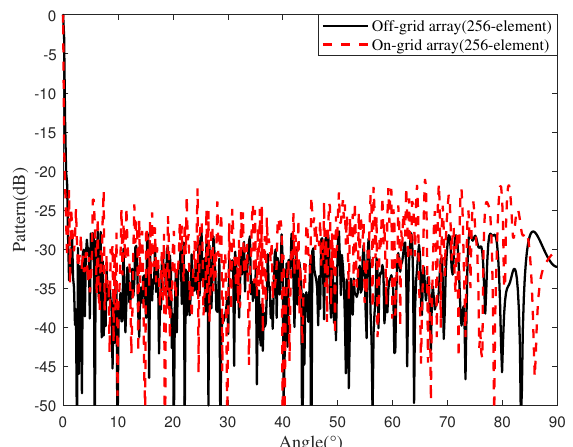
Figure 15. Beampattern of the on-grid large-scale low-frequency senor array (256-element) obtained using the proposed